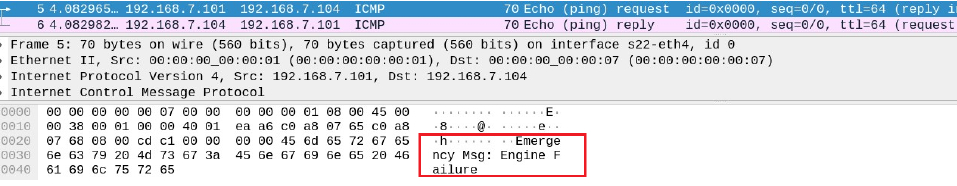
Figure 31. Wireshark: Scapy packet with a